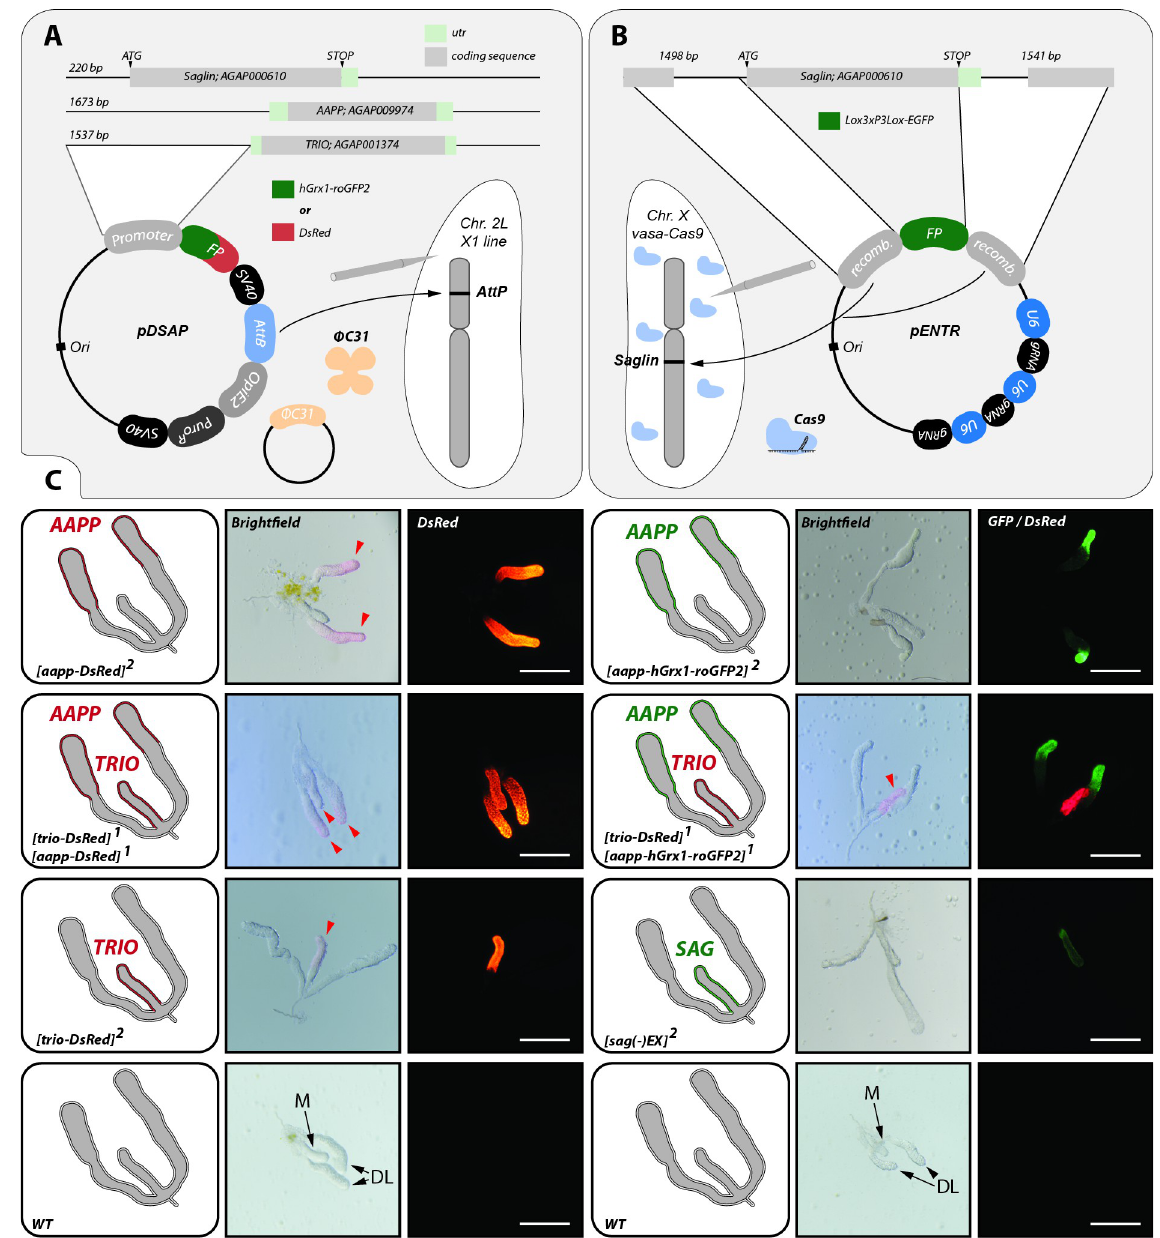
Fig 1. Lobe-specific reporter expression observed in female aapp-DsRed , aapp-hGrx1-roGFP2 , trio-DsRed and sag(-)EX mosquitoes. A) F C31 integrase-mediated transgene insertion. The aapp , trio and saglin promoter sequences were fused to DsRed or hGrx1-roGFP2 within the pDSAP vector which enables chemical selection of mosquito larvae by puromycin. Transgenes were integrated by F C31 integrase-mediated recombination into the X1 line harbouring an attP site on chromosome 2L. B) Cas9-mediated knockin of a fluorescence cassette in the saglin gene (AGAP000610). Upstream and downstream sequences of saglin were cloned into the pENTR vector flanking a fluorescence cassette expressing EGFP under the control of the 3xP3 promoter. Three guides targeting saglin controlled by U6 promoters were encoded on the same pENTR vector. Transgenesis was performed in mosquitoes with germline-specific expression of Cas9 ( vasa-Cas9 ). C) Fluorescent reporter expression in mosquitoes homozygous for trio-DsRed , aapp-DsRed , aapp-hGrx1-roGFP2 and sag(-)EX ( 3xP3 promoter excised) as well as in females heterozygous for trio-DsRed and aapp-DsRed , and trio-DsRed and aapp-hGrx1-roGFP2 . Salivary glands of wild type ( G3 ) are shown as controls. Illustrations on the left of each panel indicate the genotype of the gland as well as the observed fluorescence pattern. Images of salivary glands are shown in brightfield beside an image of the same gland in the relevant fluorescence channel. Red arrows in brightfield images highlight the pink parts of aapp-DsRed and trio-DsRed salivary glands in the absence of fluorescence excitation indicating the high expression of DsRed. Median (M) and distal-lateral lobes (DL) are indicated on the images of wild type glands. Salivary glands were dissected from 2–10 day old females that had not previously received blood feeding. Scale bars: 250 μ m.